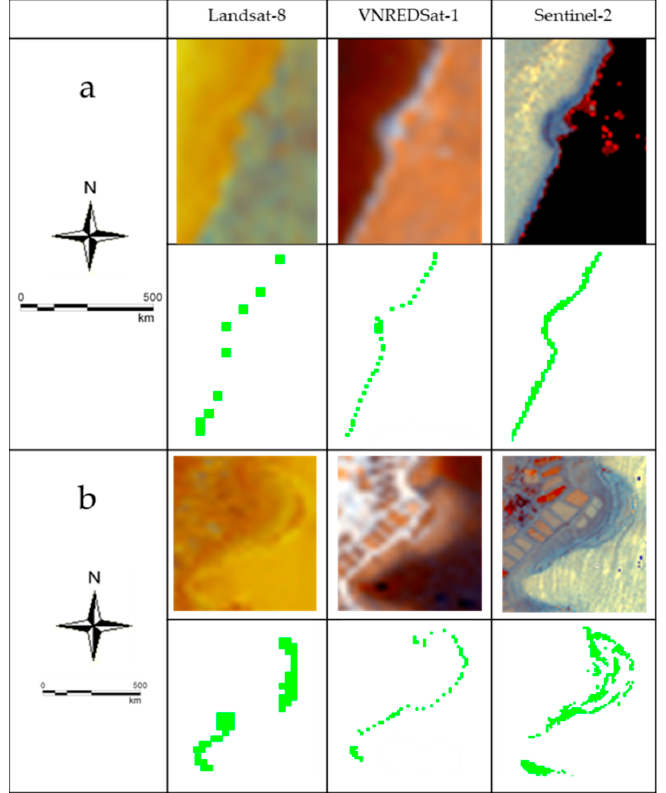
Figure 12. Examples of point and polygon SAV classifications using Landsat 8, Sentinel-2, and VNREDSat-1 imagery from the Khanh Hoa coastal area. The imagery depicts SAV areas in (a) Van Phong Bay, and (b) My Giang, Nha Phu Lagoon. ( a ) Van Phong Bay, and ( b ) My Giang, Nha Phu